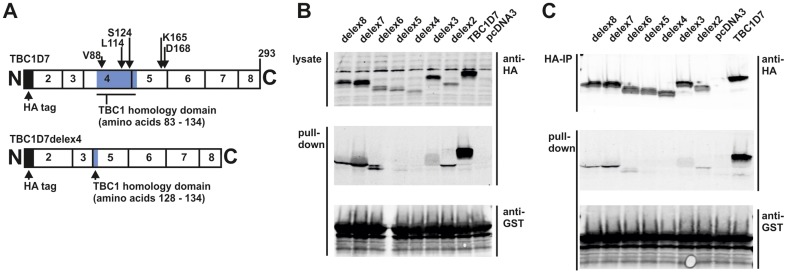
The TBC homology domain of TBC1D7 is required for the interaction with TSC1.Sequences corresponding to the individual coding exons of TBC1D7 were deleted from the HA-tagged wild-type expression construct, maintaining the original reading frame (see Supporting Information Table S2 for details). TBC1D7delex proteins were expressed in transfected HEK 293T cells and interaction with TSC1 amino acids 939 – 992 was investigated by GST pull-down assay. GST TSC1 939 – 992 was expressed in E. coli and purified on glutathione-agarose beads. A. Schematic overview of TBC1D7 (above) and TBC1D7delex4 (below) showing the segments corresponding to each coding exon and the TBC-homology domain (shaded blue). Wild-type TBC1D7 and all the TBC1D7-derived delex proteins carried an N-terminal HA epitope tag, indicated as a filled (black) segment. The positions of amino acids tested for their involvement in TSC1 binding are indicated. B. Immunoblot analysis to show expression of the TBC1D7delex proteins in transfected HEK 293T cells (upper panel) and their retention on glutathione beads bound with GST-TSC1 939 – 992 (middle panel). The GST fusion protein used for the pull-down is shown in the lower panel. C. Immunoblot analysis to show recovery of the TBC1D7delex proteins by immunoprecipitation (upper panel) and their retention on glutathione beads bound with GST-TSC1 amino acids 939 – 992 (middle panel). The GST fusion protein used for the pull-down is shown in the lower panel.